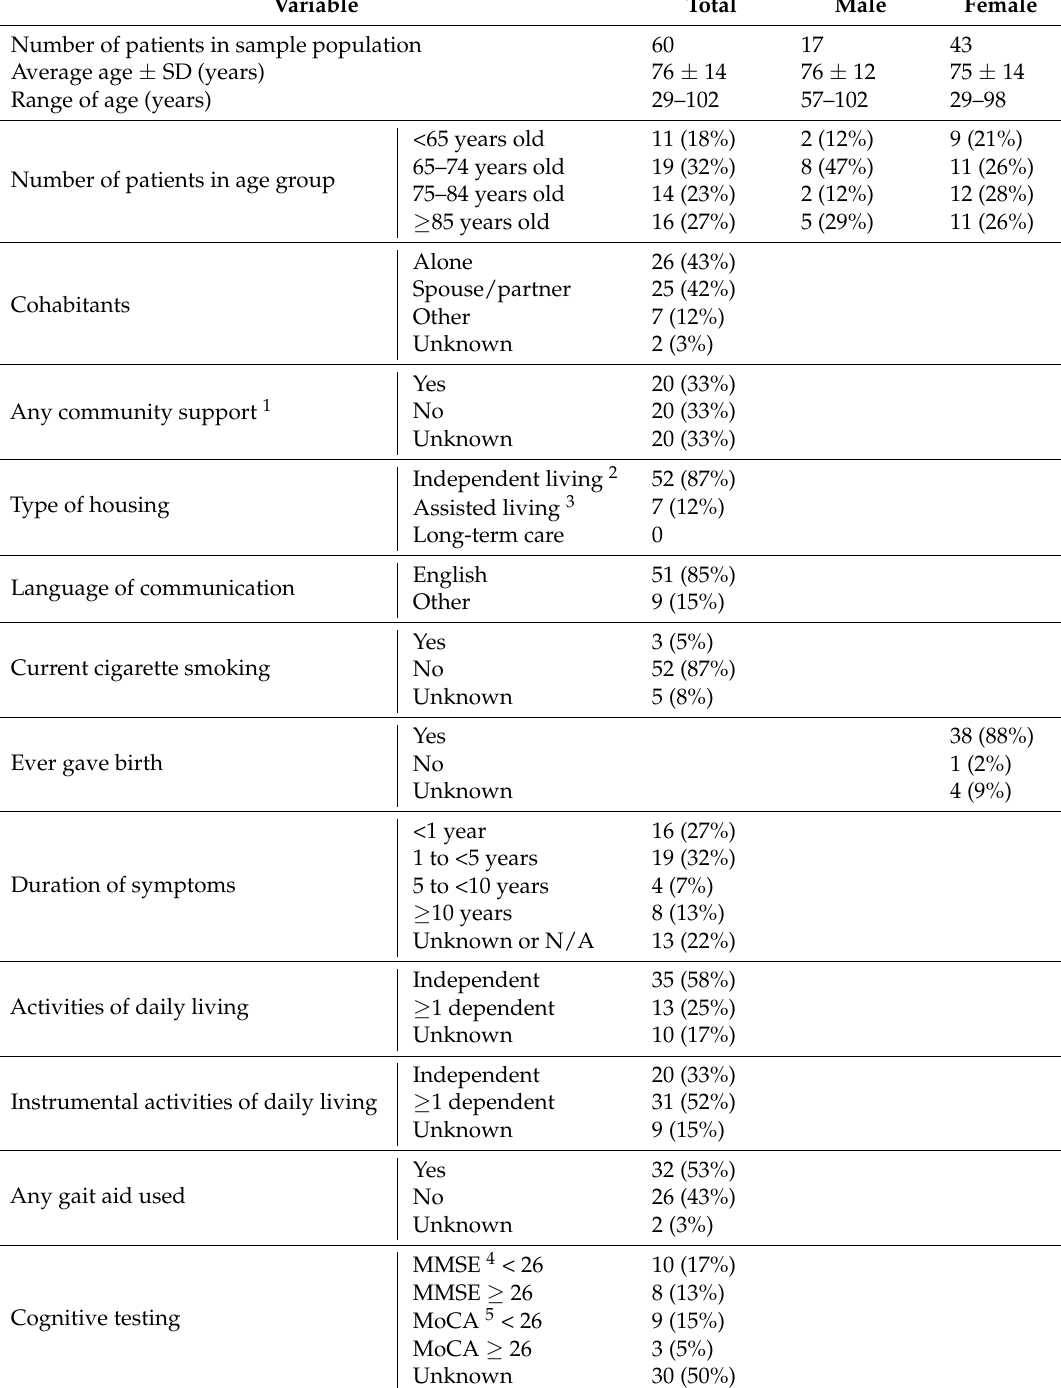
Table 1. Demographics and other characteristics of the study